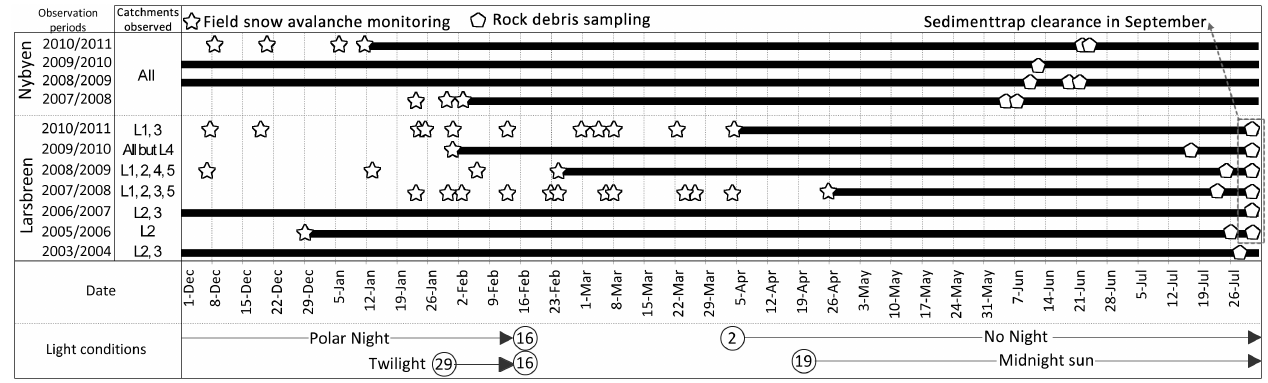
Fig. 2. Timing of annual avalanche monitoring and rock sediment collection for each slope system. The black lines indicate periods with daily automatic time-lapse photography. The stars indicate field avalanche monitoring on-site, and the pentagons indicate rock sediment collection on avalanche snow deposits. The sediment traps at the Larsbreen catchments were all emptied in early September between 2005/2006 and 2010/2011. In the lower part of the figure, light conditions are indicated with the date (number in circle) when seasonal changes